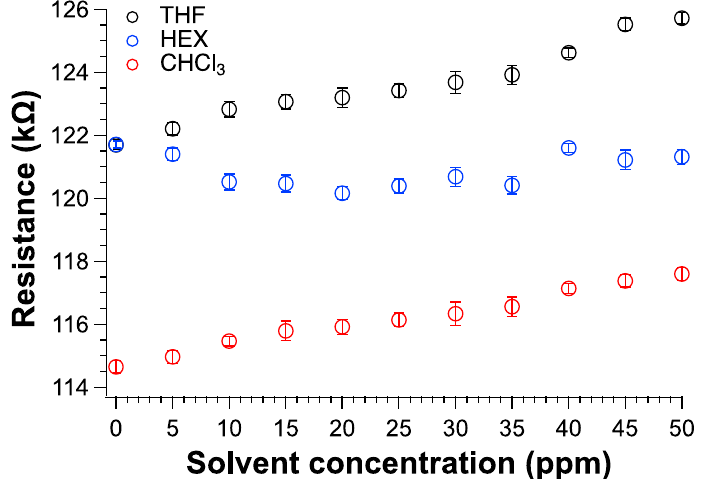
Figure 9. Resistance variation of TPSA-rGO as a function of VOC concentration expressed in ppm.